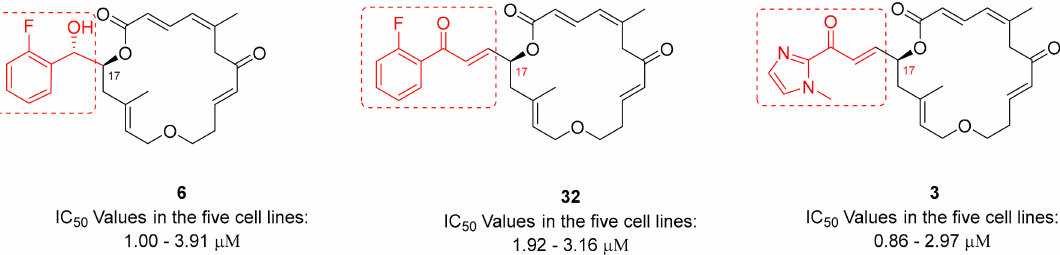
Figure 3. Comparison of antiproliferative potency among di ff erent zampanolide